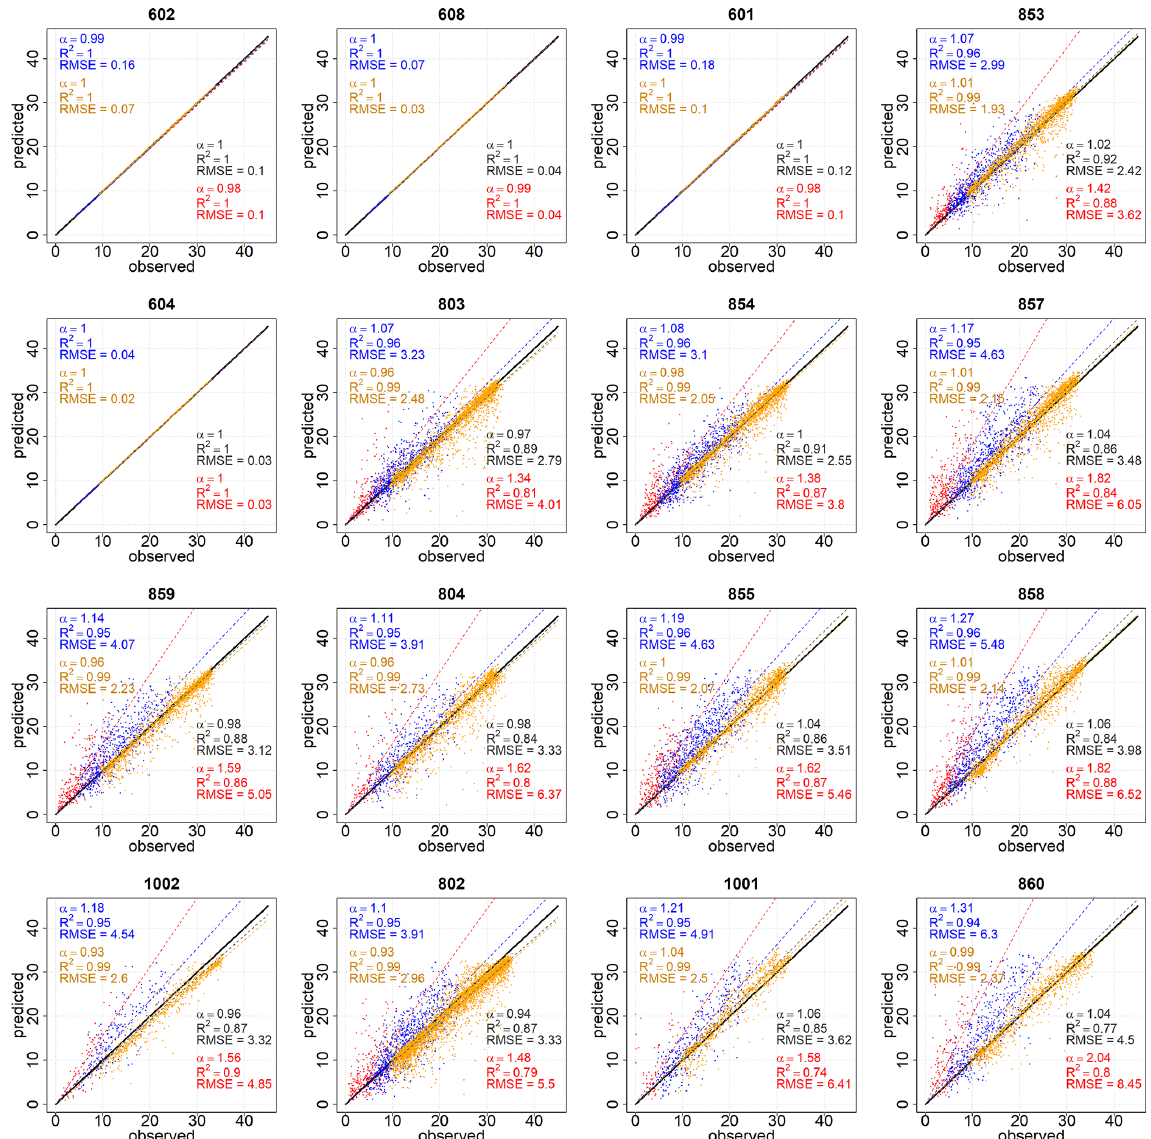
Figure B2. Linear fits of daily predicted with limited input data vs. observed R g (MJm − 2 d − 1 ) at each one of the selected stations for the global data (black) and cloudy (CI < 0.3 – red), partly cloudy (0.3 < CI < 0.6 – blue), and clear-sky (CI > 0.6 – orange) days. Stations are sorted by increasing altitude from left to right and from the top to the bottom